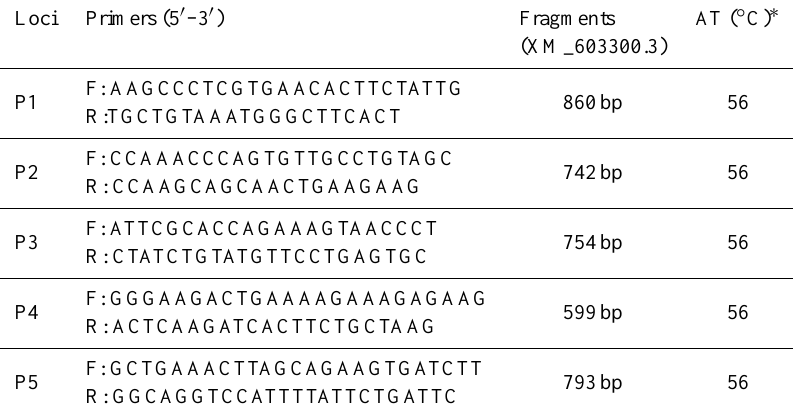
Table 1. Primer information for PCR amplification of bovine NRIP1 gene. Loci Primers (5 (cid:48) –3 (cid:48)